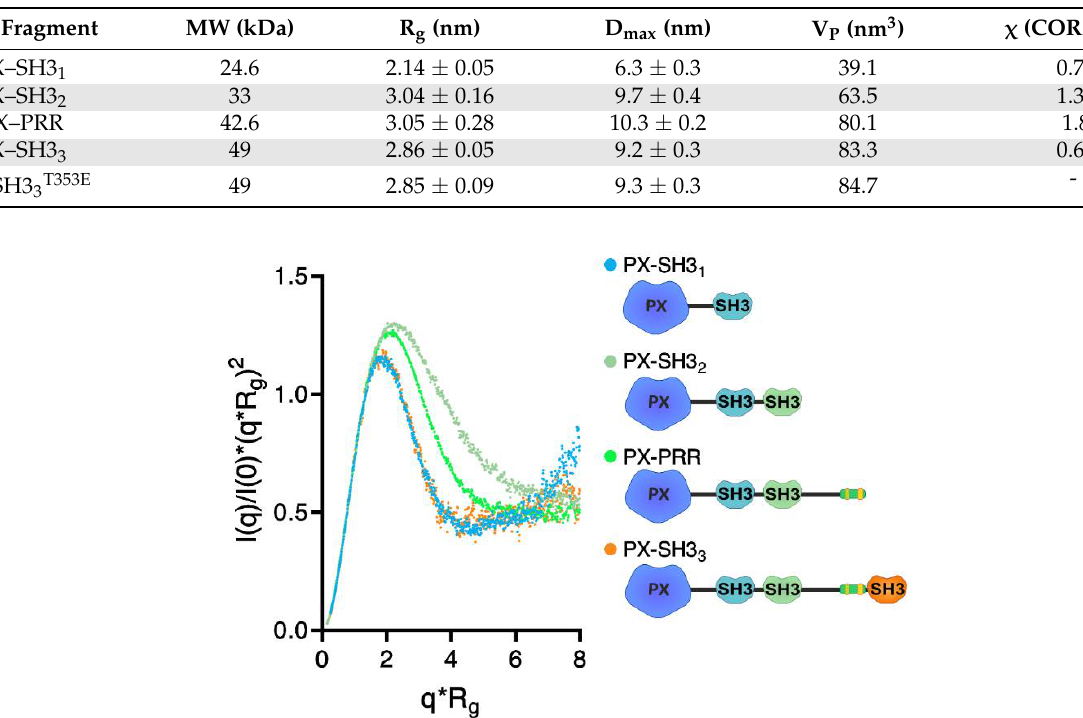
Table 2. Structural parameters determined via SAXS. MW: calculated molecular weight, R g : radius of gyration, D max : maximal length, V P : Porod volume, χ: chi value (CORAL modeling). Estimated parameters are shown with their respective standard errors.